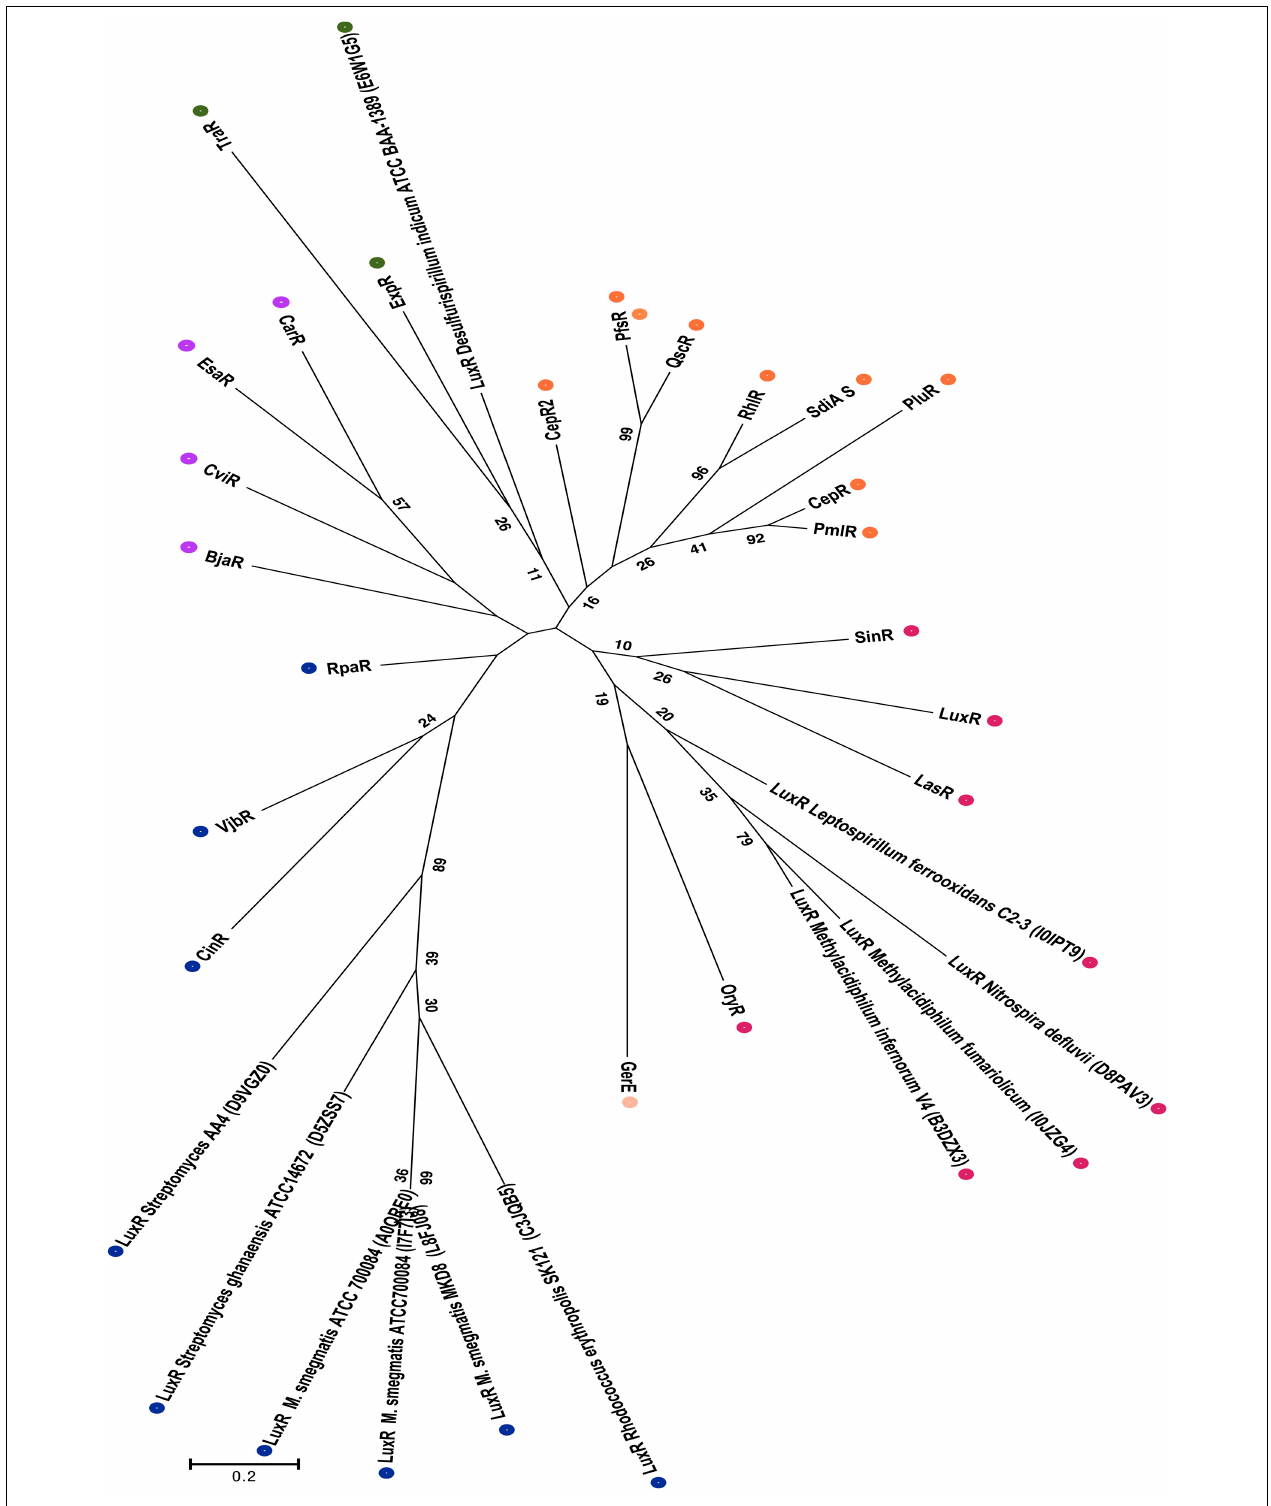
FIGURE 3 | Phylogenetic analyses of non-proteobacterial LuxR solos. This evolutionary history was inferred by using the Maximum Likelihood and the unrooted tree with the highest log likelihood is shown. The tree is drawn to scale, with branch lengths measured in the number of substitutions per site, and colored dots indicate different groups as discussed in the results